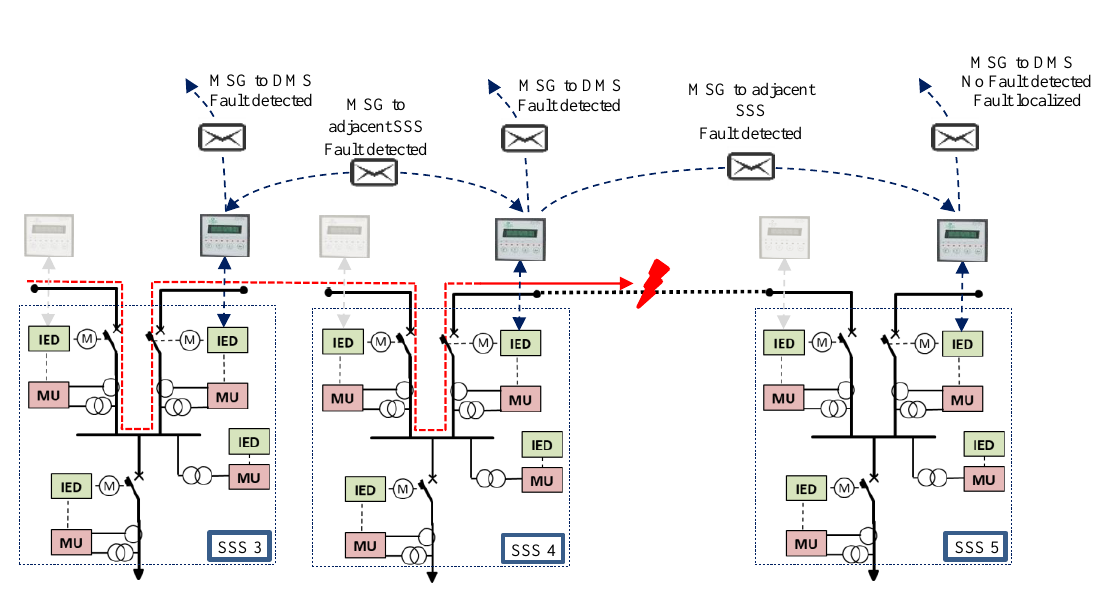
Figure 6. Fault detection and extinction in meshed distribution network.